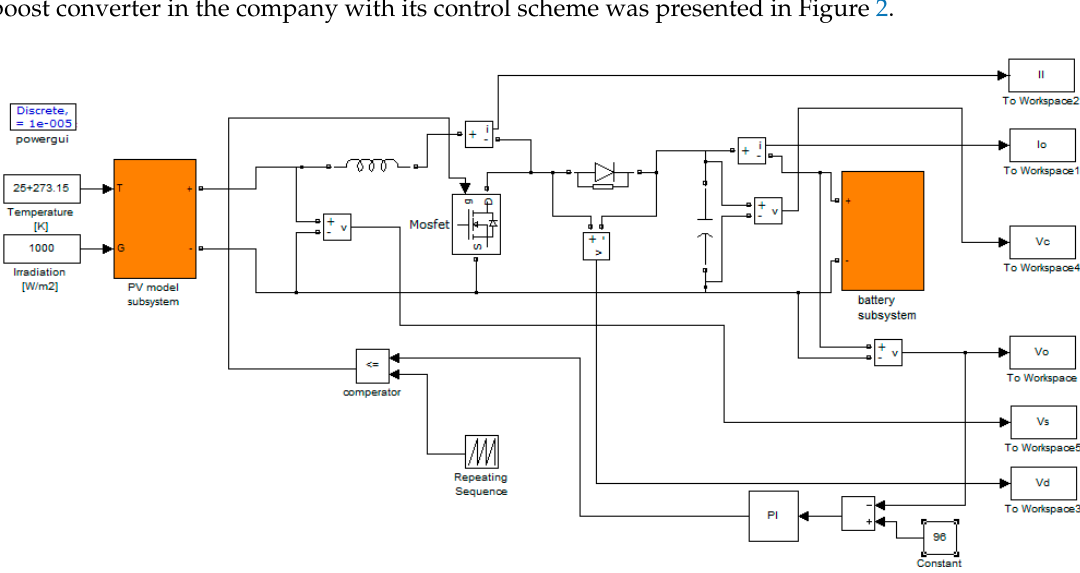
Figure 2. The general view of the MATLAB/SIMULINK model of the boost converter with the PV array and the battery.